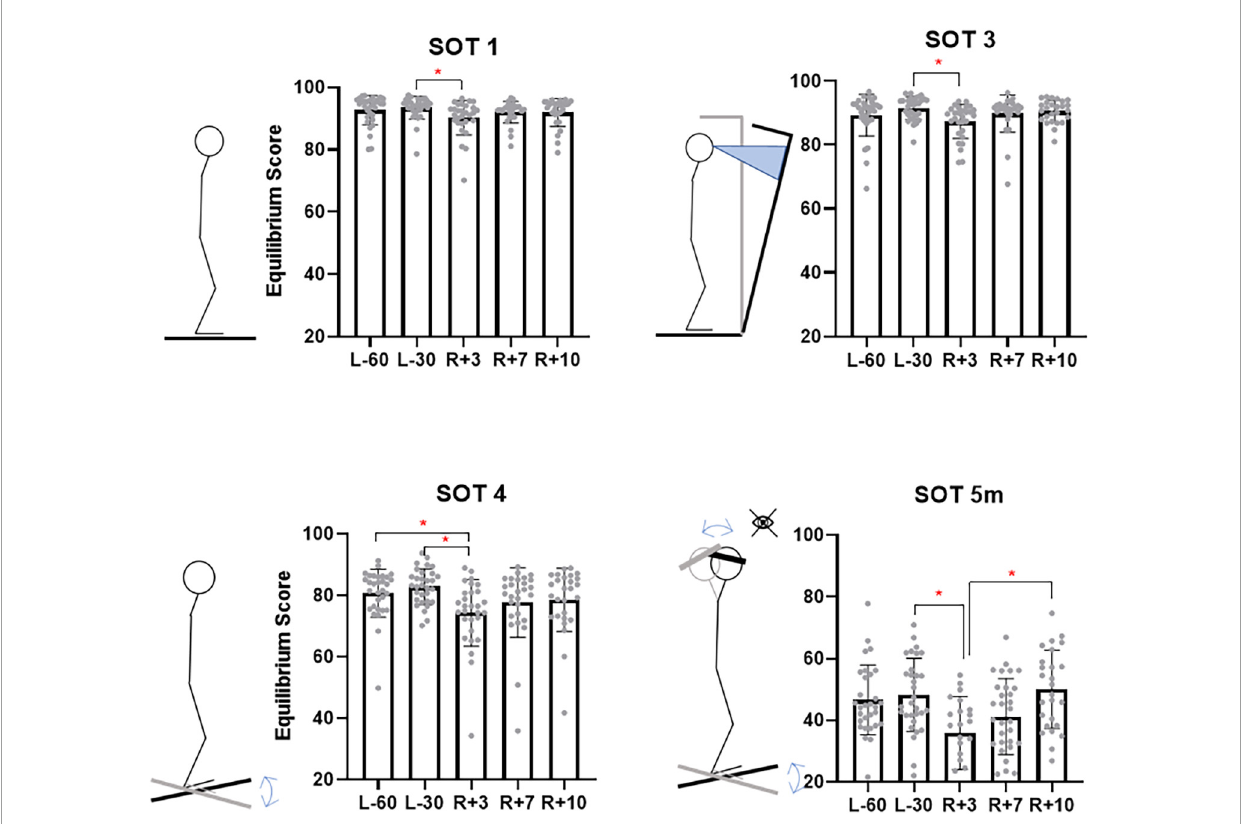
FIGURE5 Sensory organization tests with significant changes between pre- and postflight Equilibrium Score. L-60 – 60 days before launch, L-30 – 30 days before launch, R + 3 – 3rd day of recovery period after landing, R + 7 – 7th day after landing, R + 10 – 10th day after landing.